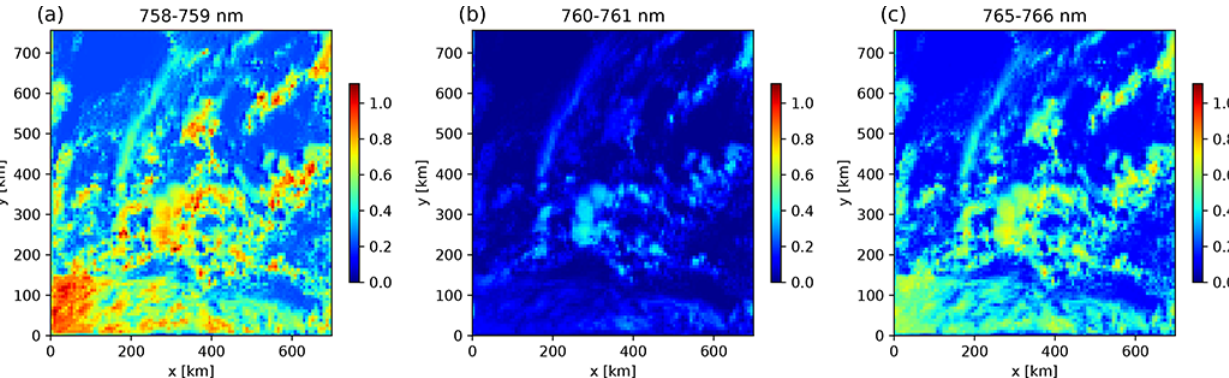
Figure 14. Band averaged reflectance simulations in the O 2 A-band region: (a) 758–759nm, (b) 760–761nm and (c) 765–766nm.